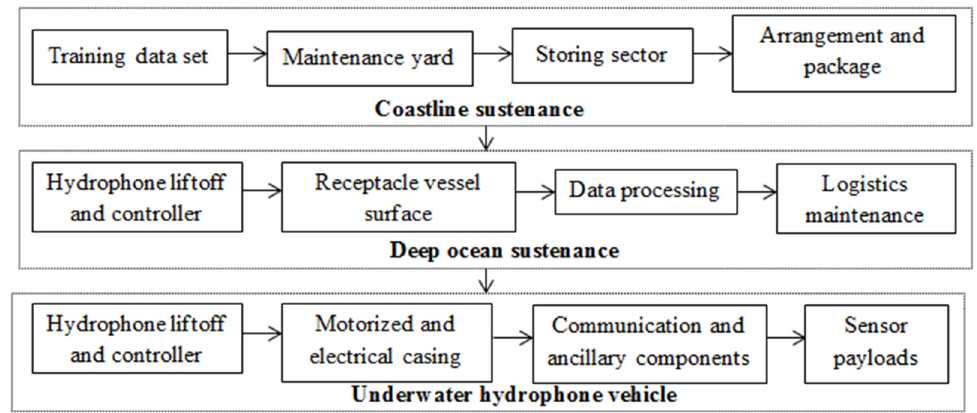
Figure 1. Integration of hydrophone sensors in underwater